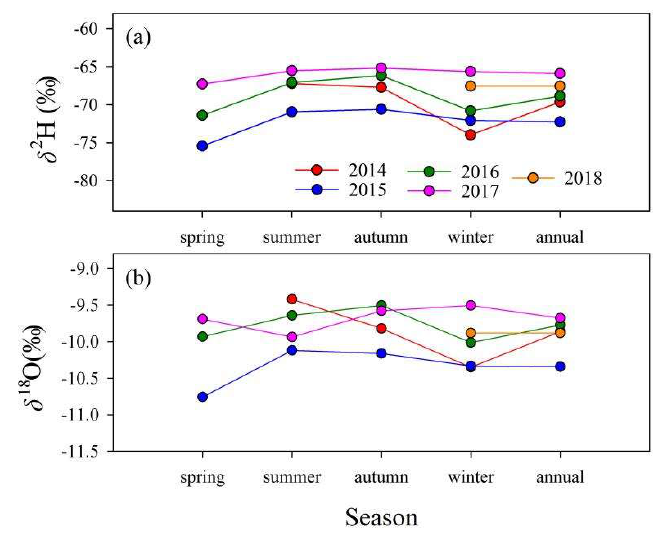
Figure 4. Interannual variations of stable isotope ratios in tap water at the sampling site of Qiujiawan (T-4) in Lanzhou from August 2014 to February 2018. ( a ) δ 2 H, ( b ) δ 18 O.